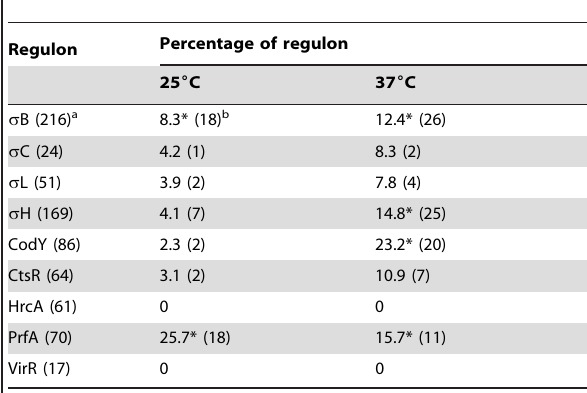
Table 1. Number of genes from sigma factors and other transcriptional regulators regulons with significant variations of transcripts between L. monocytogenes DG125A and L. monocytogenes EGD-e at 25 u C and 37 u C.